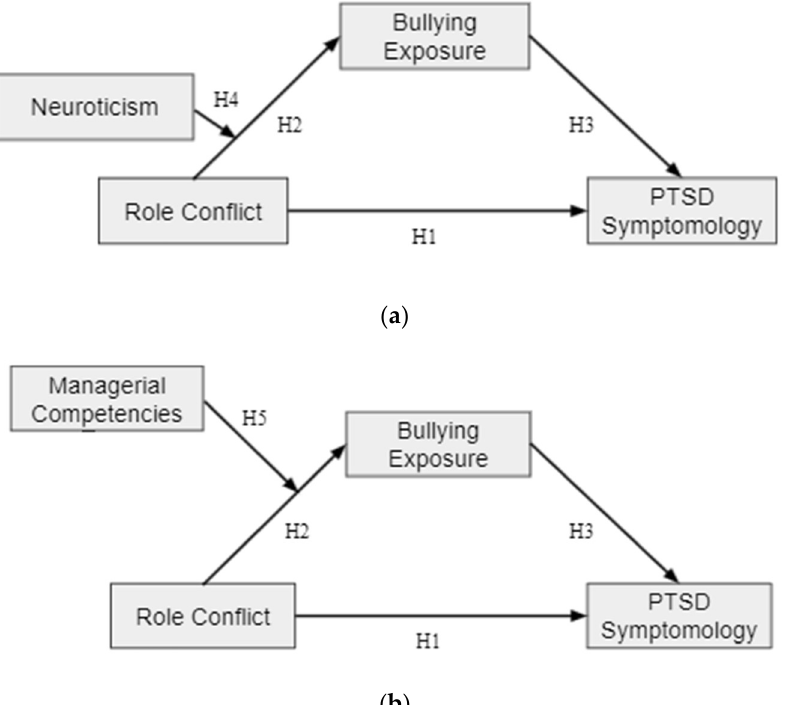
Figure 1. Moderated mediation models. ( a ) Hypothesized moderated mediation model. Neuroticism strengthens the Indirect Effect of Role Conflict and Exposure to Bullying on PTSD Symptomology. ( b ) Hypothesized moderated mediation model. Managerial competencies weaken the Indirect Effect of Role Conflict and Exposure to Bullying on PTSD